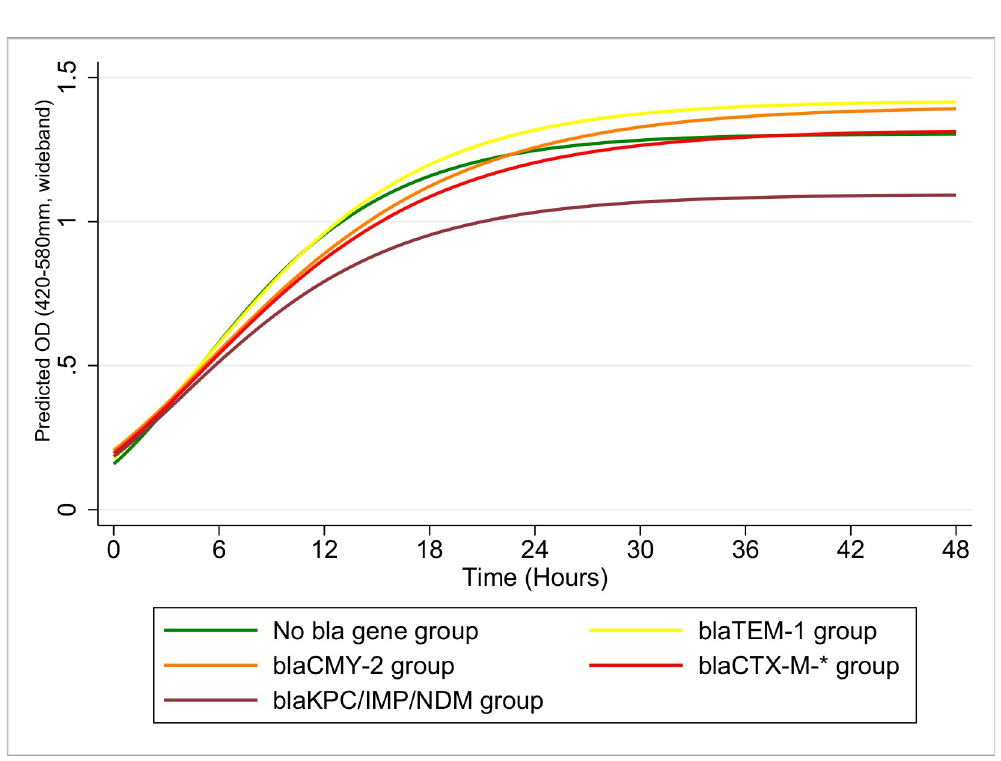
Fig 2. E . coli strains (n = 20 / bla -gene group) 3-Parameter Gompertz fitted growth curves grown in CAMH-2 broth. CAMH-2 (Cation-adjusted Mueller-Hinton II). (Green) E . coli strains lacking any beta-lactamase encoding genes, (Yellow) bla TEM-1 beta-lactamase encoding gene strains, (Orange) bla CMY-2 beta-lactamase encoding gene strains, (Red) bla CTX-M- � beta-lactamase encoding gene strains, and (Maroon) bla NDM/IMP/KPC carbapenemase encoding gene E . coli strains.